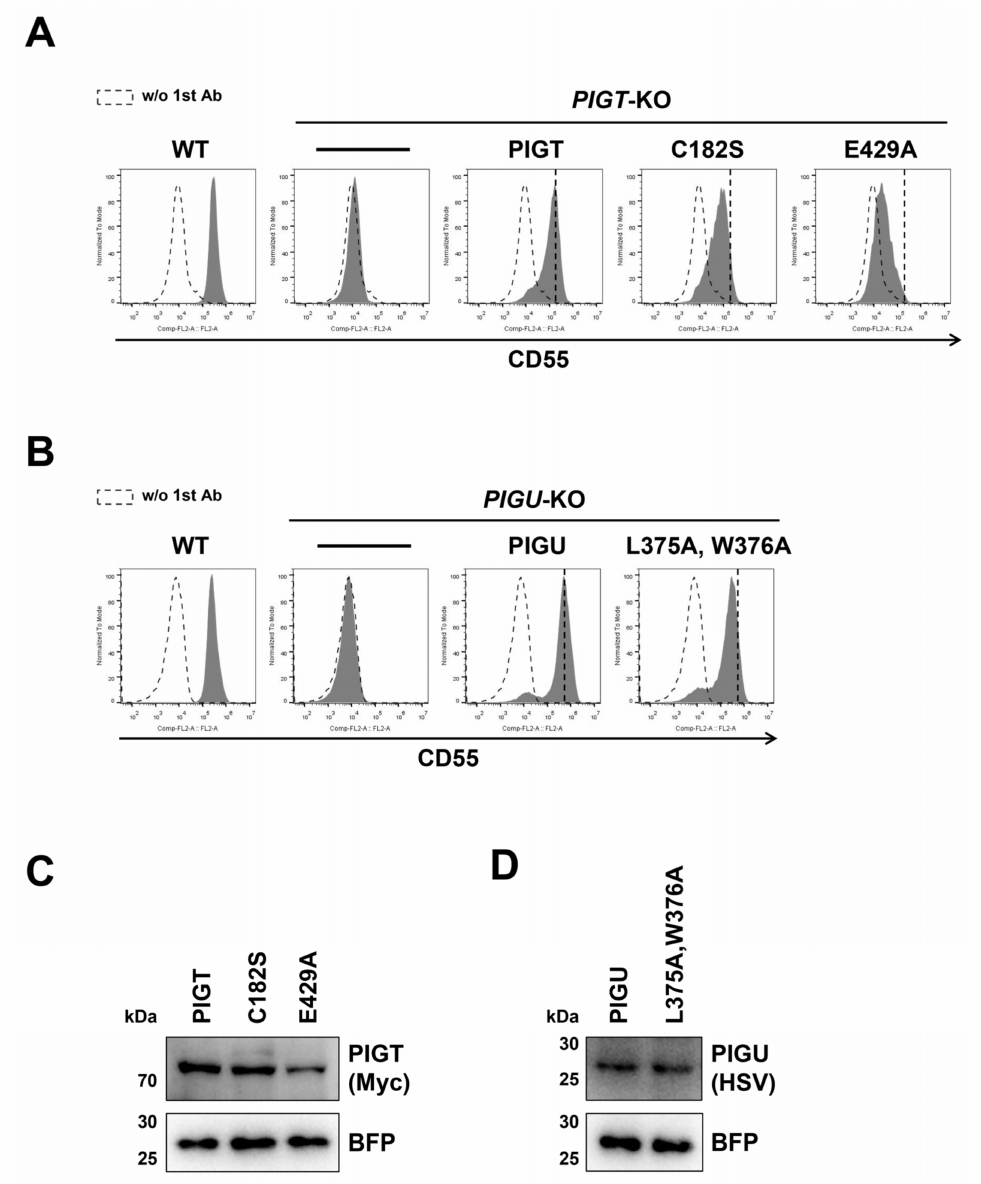
Figure 4. Functionally important residues of PIGT and PIGU. ( A , B ) Surface expression of CD55 in PIGT -KO ( A ) and PIGU -KO ( B ) cells transiently expressing wild-type or mutant PIGT-6Myc and PIGU-3HSV constructs, respectively, was analyzed by flow cytometry, as described in Figure 2A. ( C , D ) Expression of PIGT-6Myc ( C ) and PIGU-3HSV ( D ) mutants was detected by western blotting. BFP was used as a control to check the transfection levels and